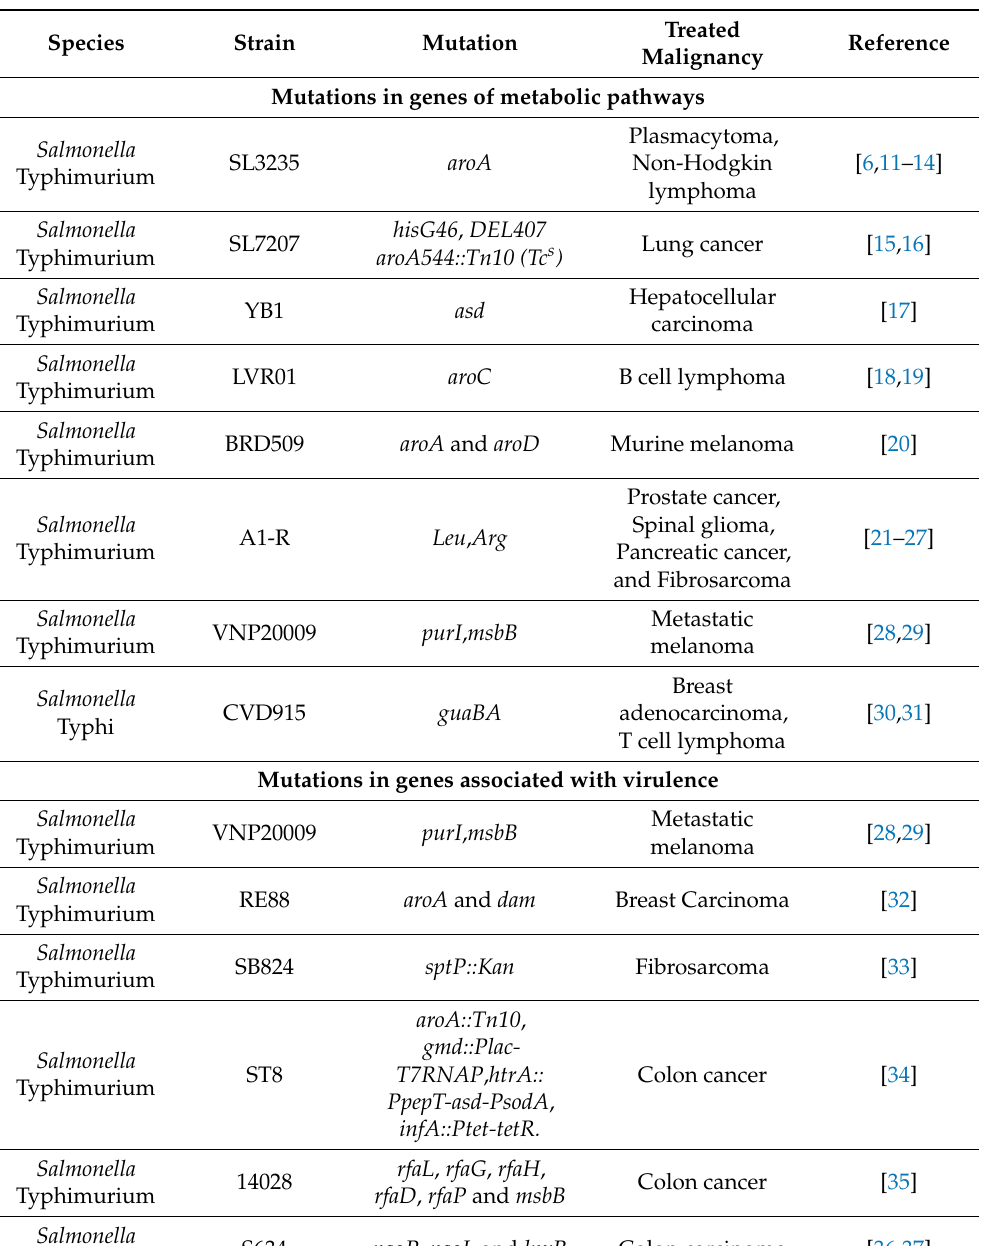
Table 1. Attenuated Salmonella enterica strains used in murine malignancy models.